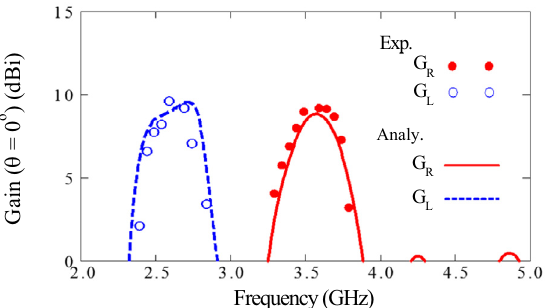
Fig. 7. Frequency response of the gain with a parasitic loop (paraloop), where H para =11 mm =0.09 wavelength at f GLmax = 2.58 GHz.